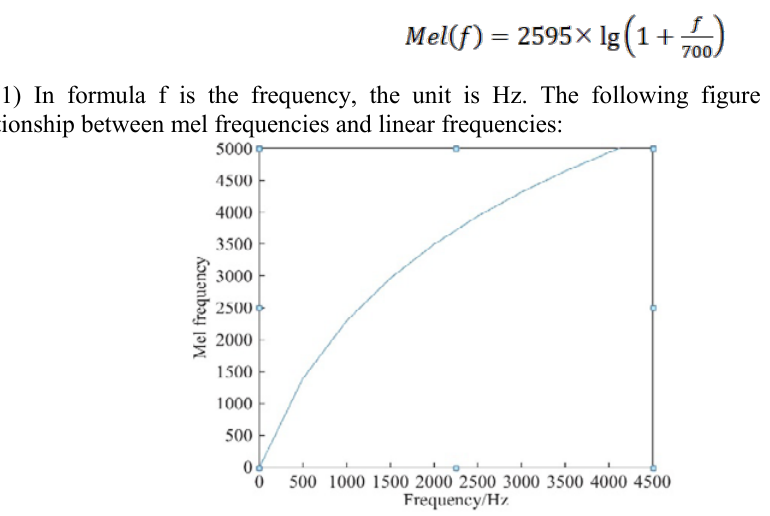
Fig. 2. Mel frequency vs. linear